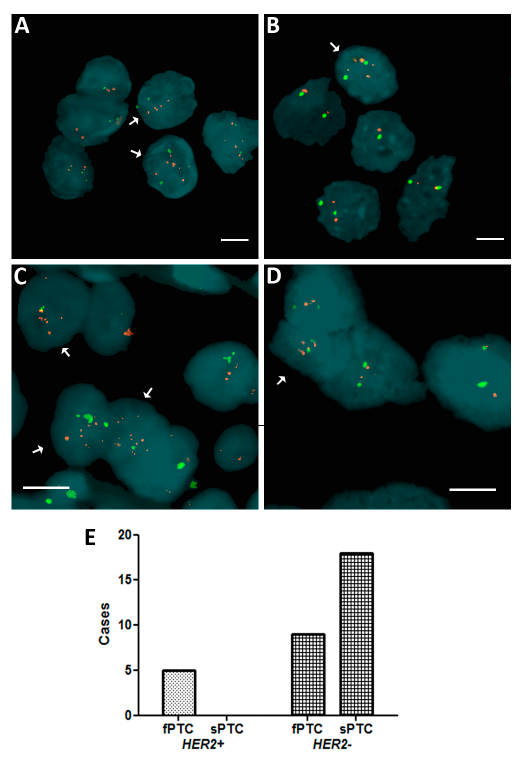
Figure 1. Distribution of HER2 ( human epidermal growth factor receptor 2 ) amplification in familial papillary thyroid carcinoma (fPTC) and sporadic papillary thyroid carcinoma (sPTC) nuclei. Arrows point to isolated nuclei with extra copies of the HER2 gene ( red spots ) in the presence of disomy 17 (chromosome 17 centromere-specific alphoid repetitive DNA, green spots ) in fPTC ( A ); and sPTC ( B ); and in nuclei in formalin-fixed paraffin-embedded (FFPE) sections of fPTC ( C ); and sPTC ( D ). The distribution of the amplification in FFPE sections of fPTC versus sPTC was significant ( p = 0.0076) (Fisher exact test) and indicative of genetic heterogeneity heterogeneity according to Vance criteria [17] ( E ). Scare bar = 10 µm.